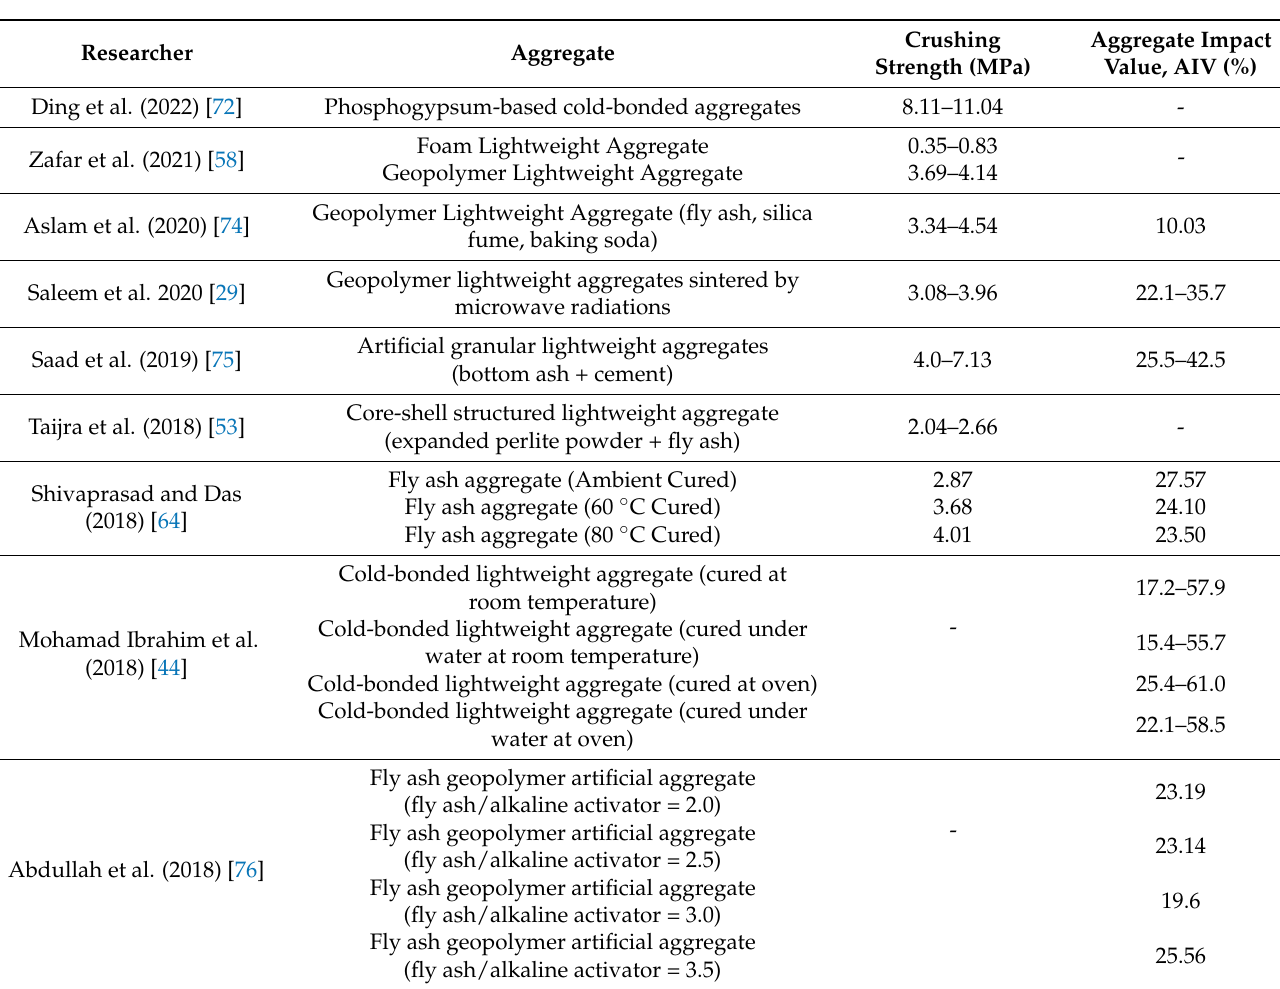
Table 4. Previous studies on mechanical properties of lightweight aggregate.